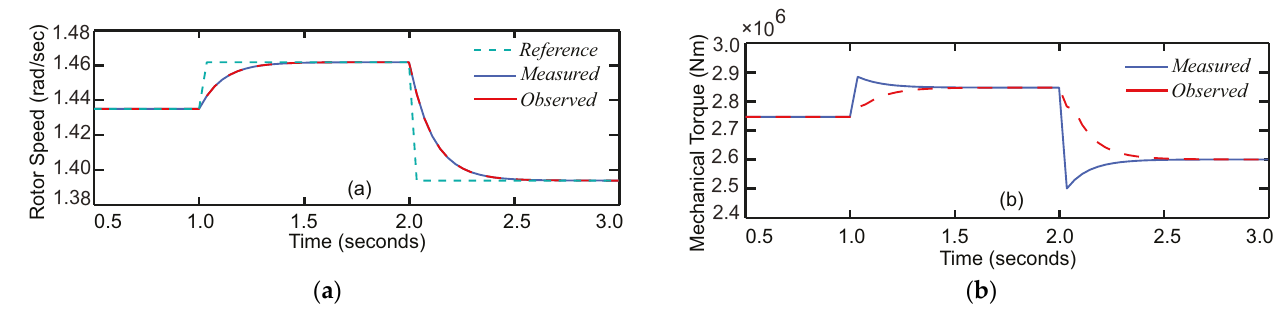
Figure 14. Mechanical output from the adaptive observer: ( a ) rotor speed 𝜔 (cid:3045) and ( b ) mechanical torque 𝑇 (cid:3040) .